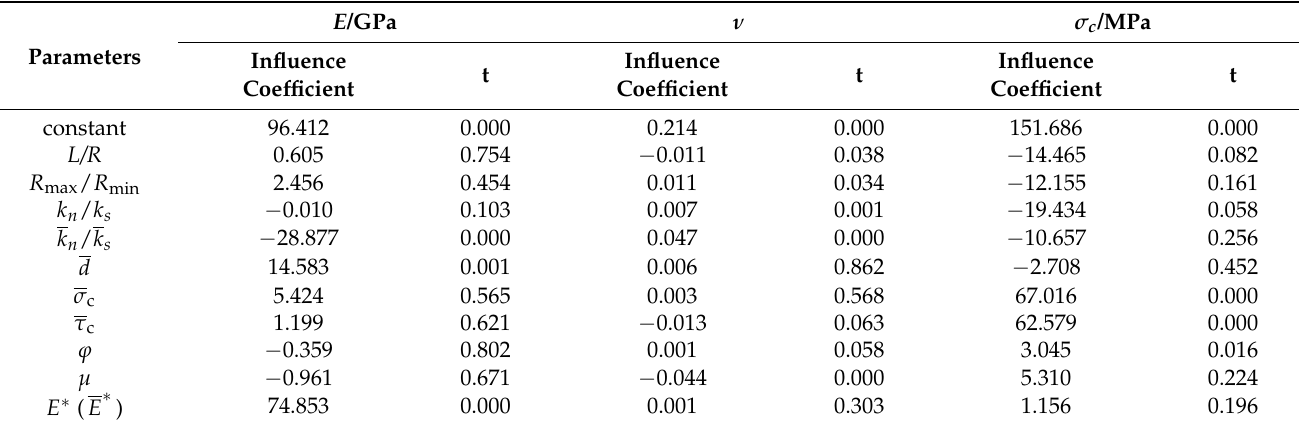
Table 3. Analysis of orthogonal test results.